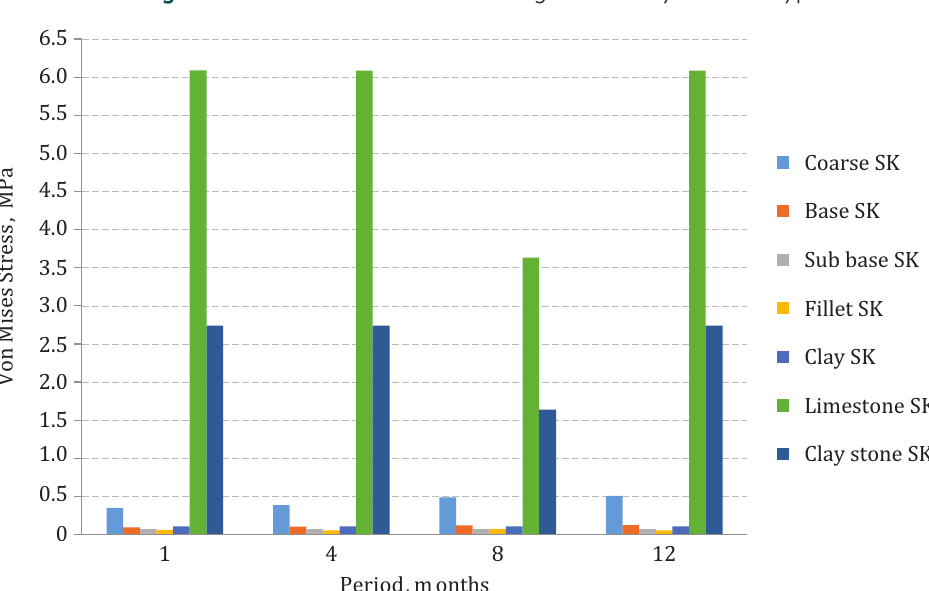
Figure 12. Von Mises stress-time changes of the layers for